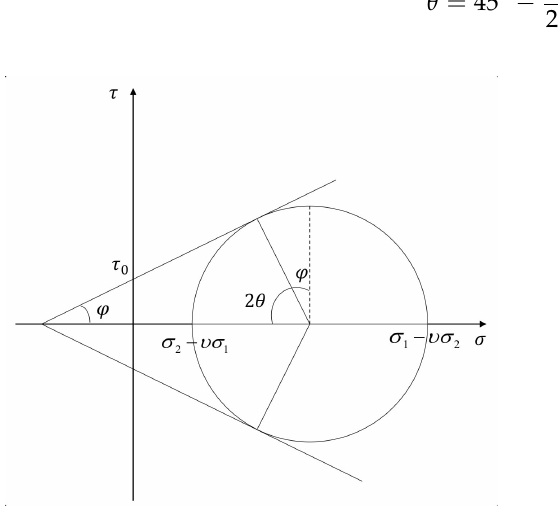
Figure 3. Mohr’s circle during a shear rupture